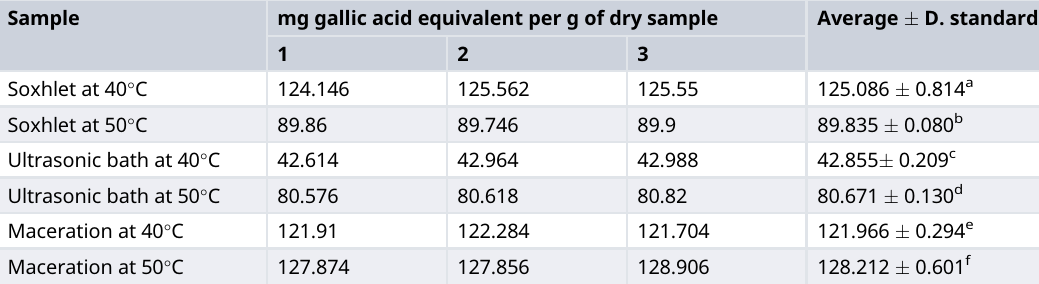
Table 7. Tukey ’ s HSD test for the flavonoid content of the different samples determined that there is a significant difference among them (p<0.05). Samples that shared the same letter are homogeneous.